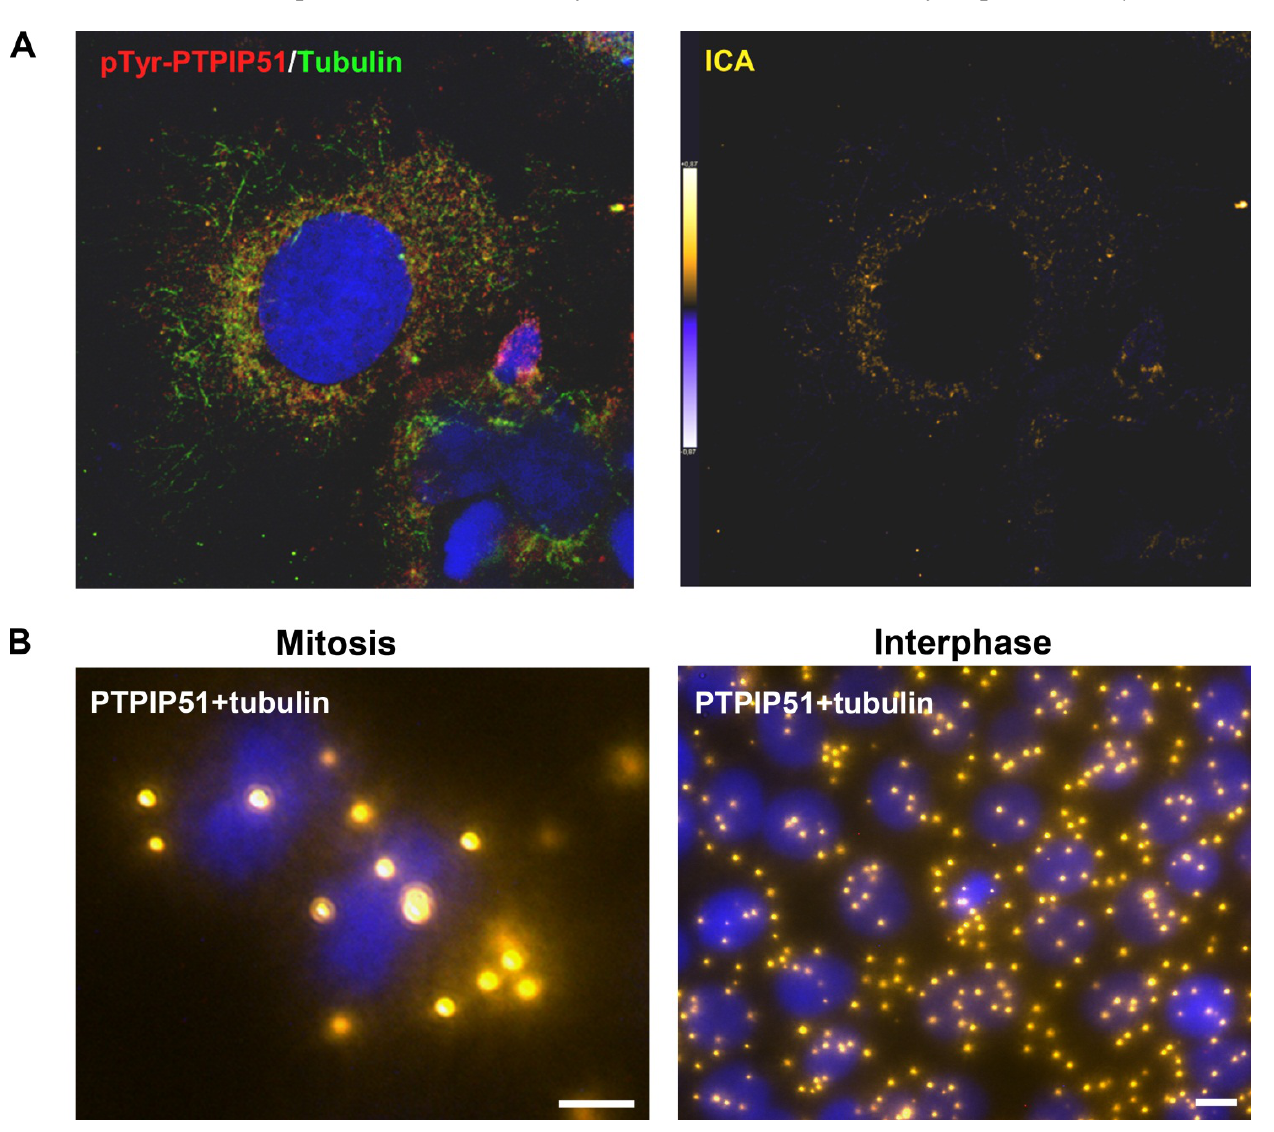
Figure 8. Tyrosine 176 phosphorylated PTPIP51 in HaCat interphase cells and PTPIP51/tubulin DuoLink proximity ligation assay (DPLA). ( A ) Confocal laser scanning microscopy of tyrosine 176 phosphorylated PTPIP51 and tubulin in interphase cell. PTPIP51 antibody: P51ab-PTyr. Nucleus marked in blue using To-Pro3. Intensity correlation analyses were carried out using the full image of pTyr-PTPIP51/tubulin as input. The co-localization of PTPIP51 and tubulin is displayed in orange. Sites of non-co-localization are marked in blue. ( B ) DPLA of PTPIP51 and tubulin in mitosis and DPLA of PTPIP51 and tubulin in interphase. PTPIP51 antibody: P51ab. Nuclei are marked by Dapi. Bars: 10